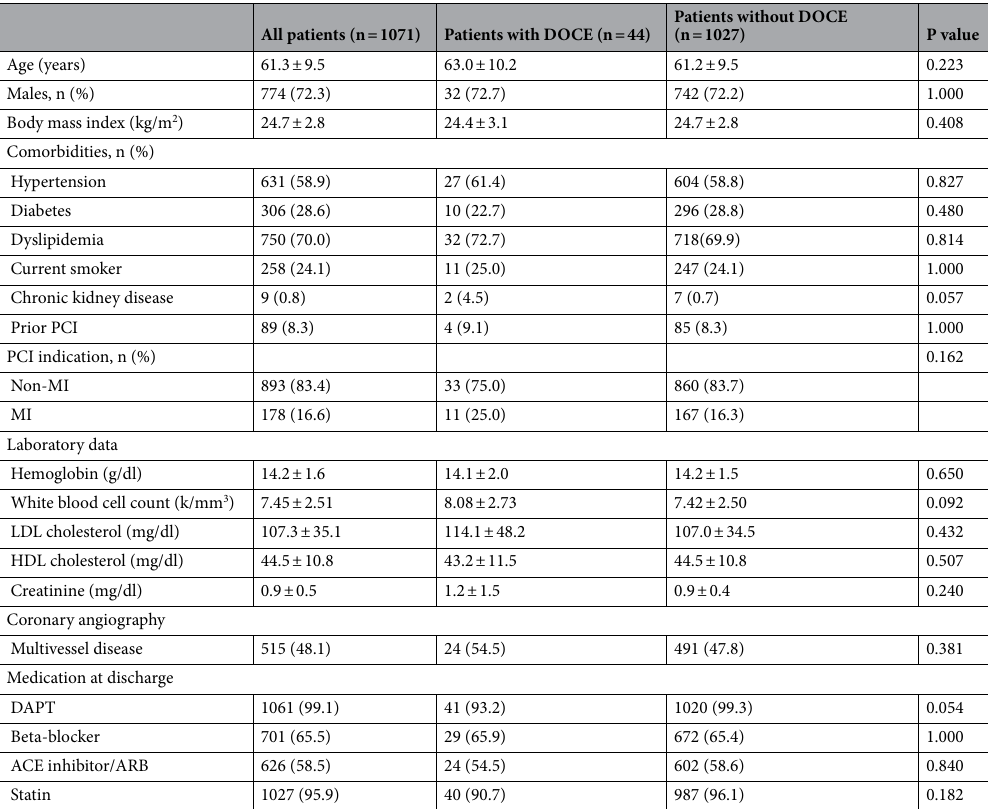
Table 1. Patient characteristics. ACE angiotensin-converting enzyme, ARB angiotensin II receptor blocker, DAPT dual antiplatelet therapy, DoCE device-oriented clinical end point, HDL high-density lipoprotein, MI myocardial infarction, LDL low-density lipoprotein, PCI percutaneous coronary